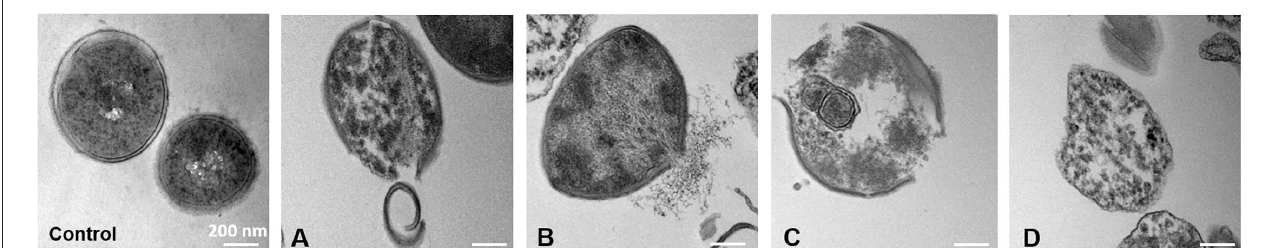
FIGURE6 TEM images of Staphylococcus aureus within 3h treatment with 0.16mM of C 12 MIMCl. (A-D) : The destruction process of Staphylococcus aureus by C 12 MIMCl.